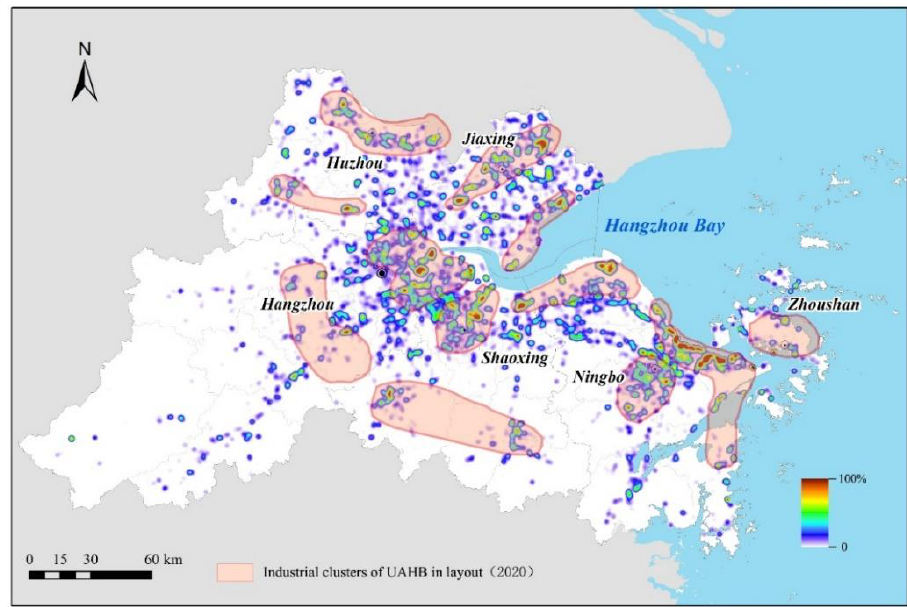
Figure 13. The map of UAHB’s industrial layout and spatial distribution of industrial clusters.